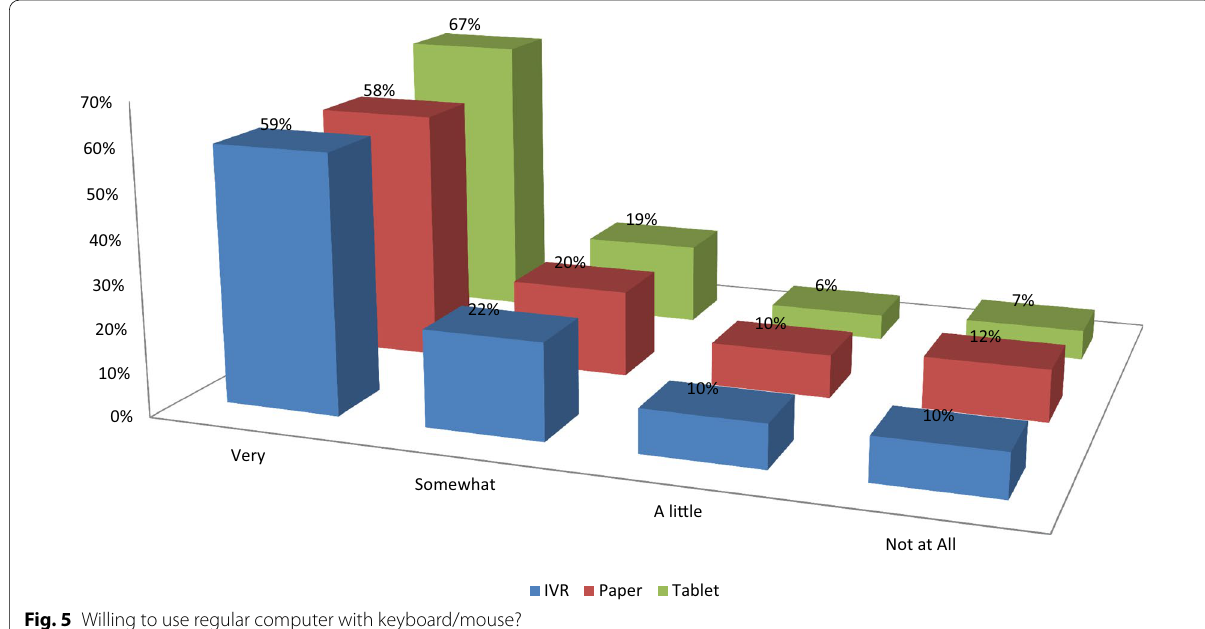
Fig. 5 Willing to use regular computer with keyboard/mouse?